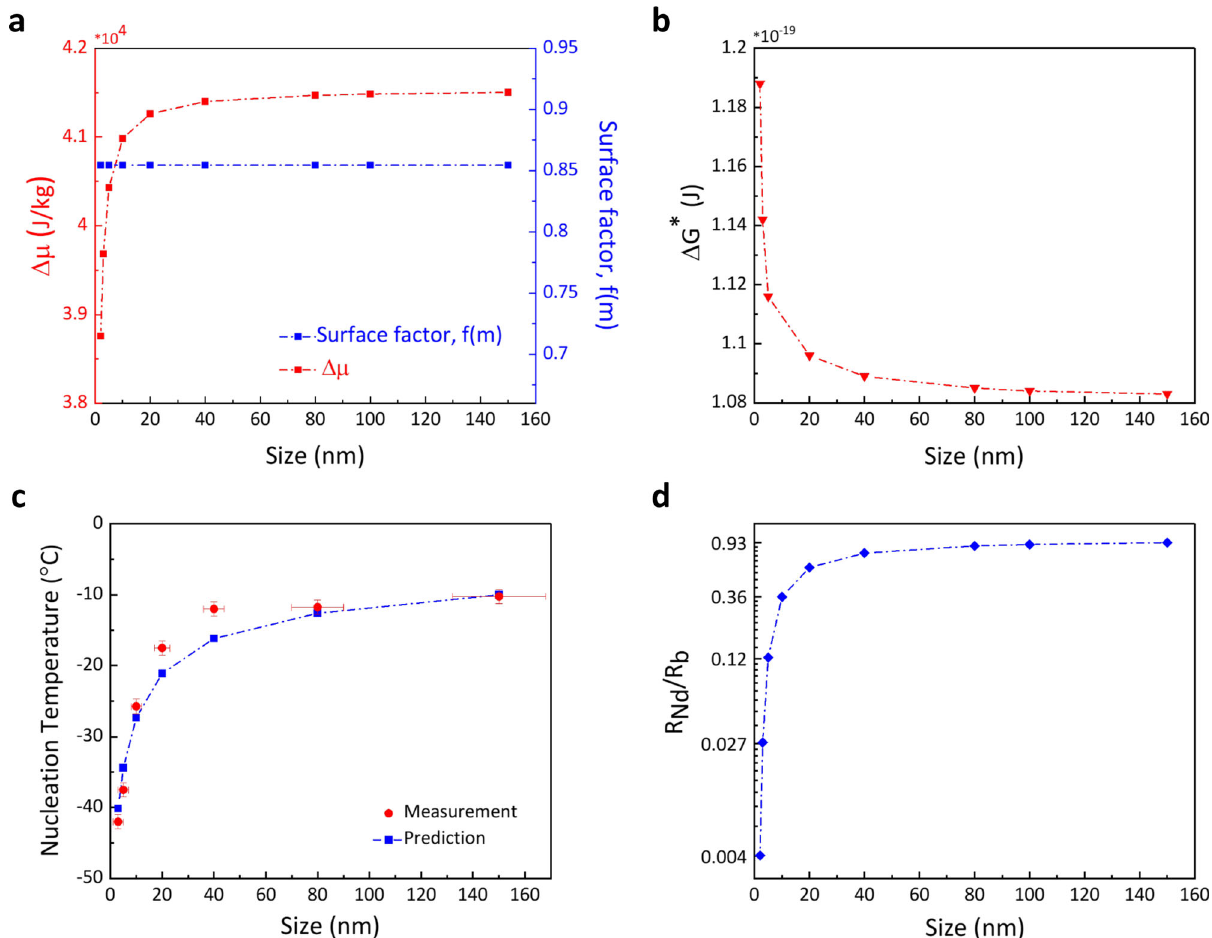
Fig. 4 Gibbs energy barrier for freezing of nanoscopic water droplets. a The dependence of chemical potential difference on length-scale is shown at T = − 41 °C. Due to the interfacial deformation, the role of interfacial curvature on surface function can be neglected and f ð m Þ is considered constant for all sizes. b The Gibbs energy barrier for water – ice phase change of nanodroplets is shown as a function of the diameter of nanodroplets at T = − 41 °C. c The predicted ice nucleation temperature by CNT for various drop sizes is compared with the averaged measured T N by two metrologies. The horizontal error bars denote variations in the dimension of the water droplets, and the vertical errors bar denotes experimental errors in the measurement of nucleation temperature. d The normalized ice nucleation rate of nanodroplets with respect to bulk water is shown as a function of length-scale at T = 41 °C. The nucleation rate drops by more than two orders for a 2 nm